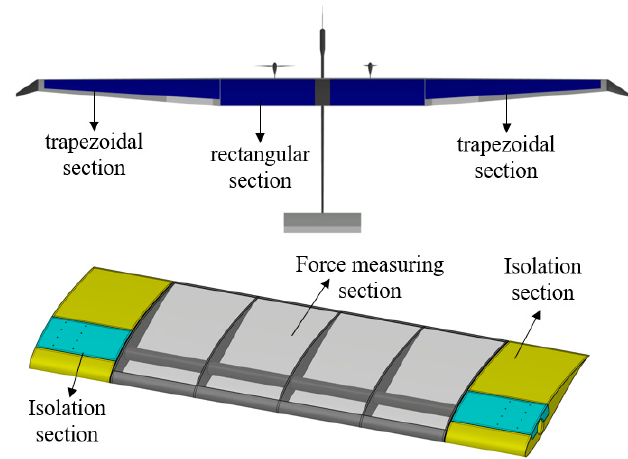
Figure 1. Double membrane wing of the solar UAV.